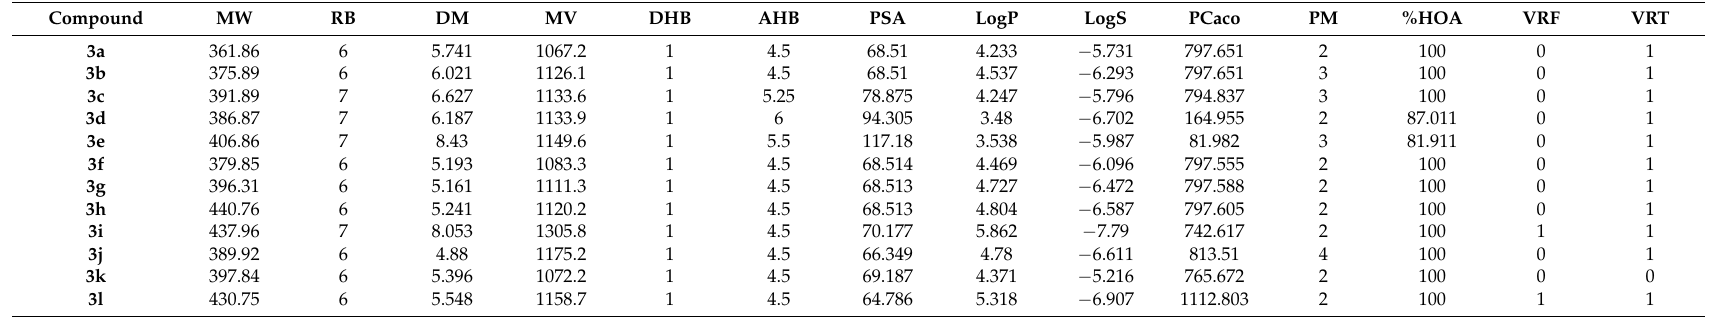
Table 3. Calculated absorption, distribution, metabolism, and excretion (ADME) parameters of compounds 3a – 3l